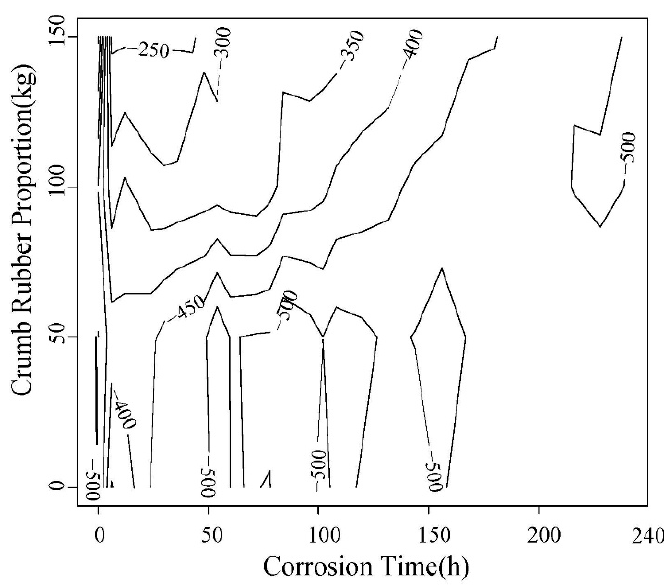
Figure 8. The trend of the corrosion potential value of steel bar in 0.45 water-cement ratio.